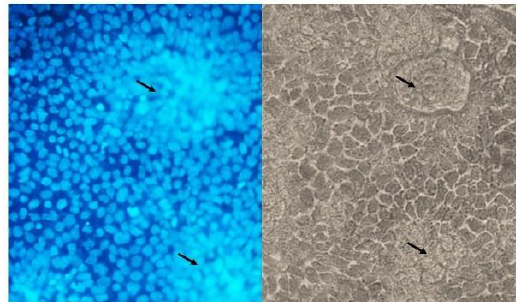
Figure 5. Microphotograph of the Caco-2/HT-29 co-culture seeded on the Transwell insert at a 9:1 ratio and cultured for 18 days. Morphological features were examined with DAPI staining (on the left ). Black arrows indicate HT-29 clusters inside the differentiated Caco-2 cell monolayer, 20× mag- nification.